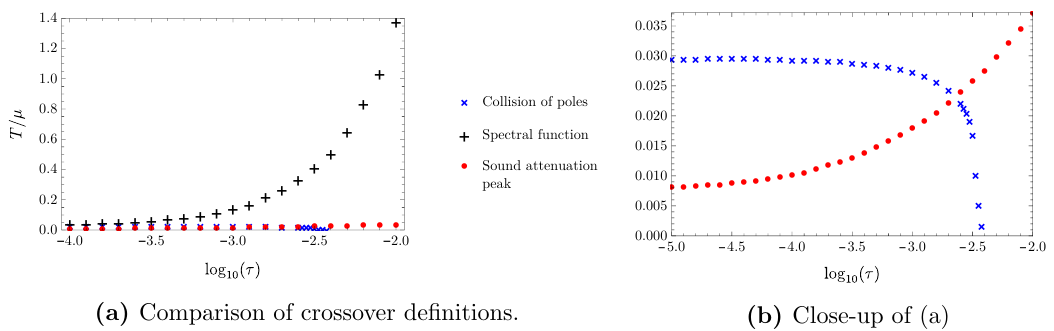
Figure 21. Our numerical results for the crossover value of T=(cid:22) as a function of log (cid:12)xed ~ (cid:11) = 1, using the three di(cid:11)erent de(cid:12)nitions: the probe limit de(cid:12)nition, via a collision of poles that produces the charge di(cid:11)usion pole (blue crosses), the AdS-RN de(cid:12)nition, via a transfer of dominance from sound to charge di(cid:11)usion peak in (cid:26) J (black plus signs), and the LFL de(cid:12)nition, via the sound attenuation maximum (red